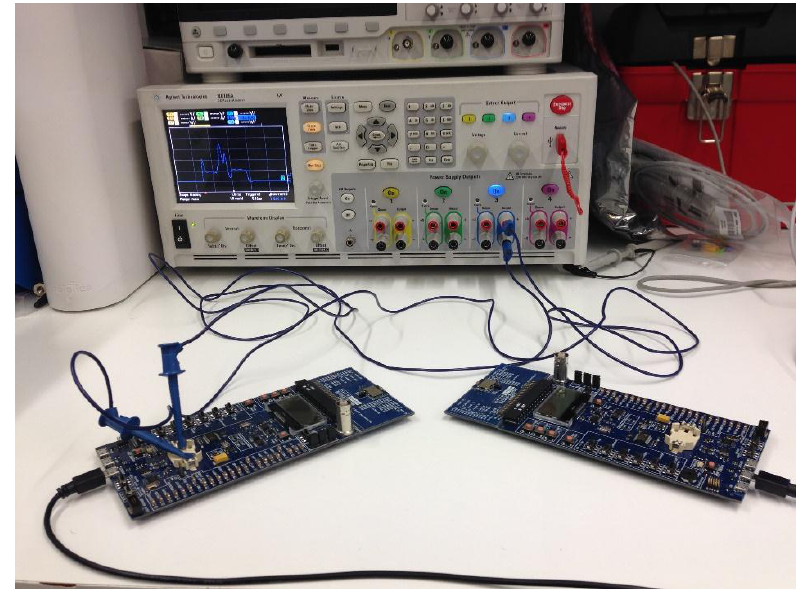
Figure 3. Experimental setup for current measurements of the BLE121LR modules using an Agilent N333 power analyzer. The module at the left works as a slave that connects to the module at the right, which operates as a master.